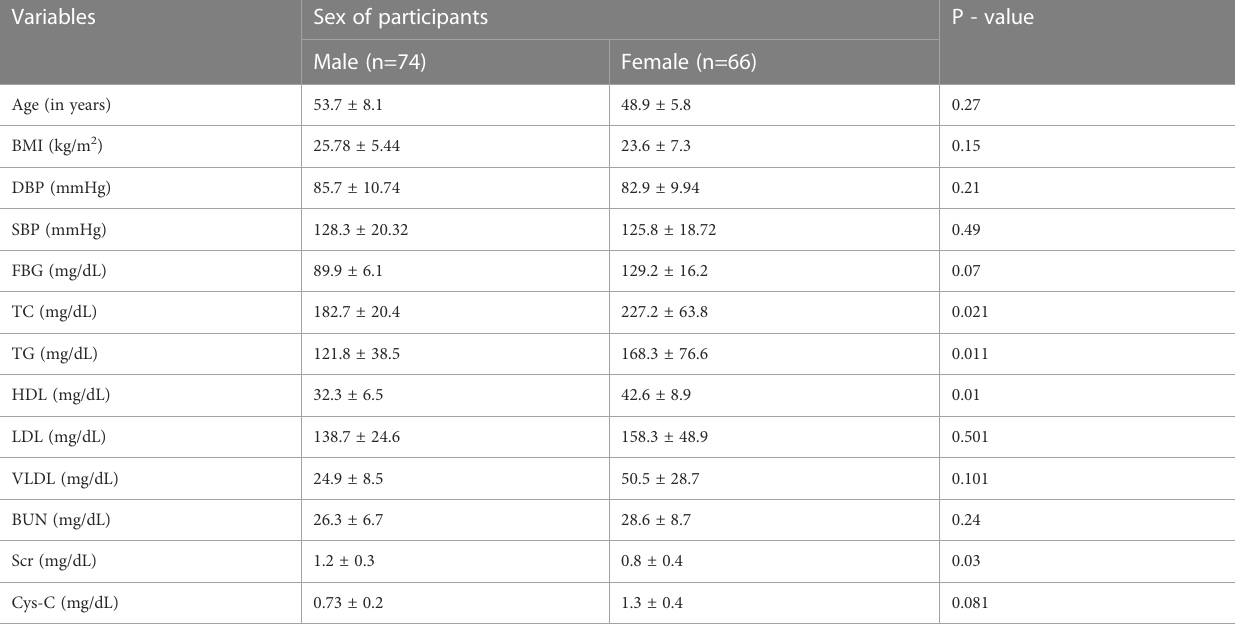
TABLE 3 Comparison of clinical and biomedical parameters between males and females. . Variables